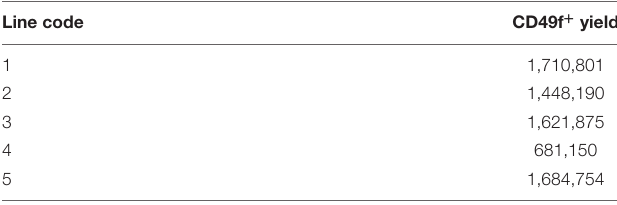
TABLE 4 | Human induced pluripotent stem cell -derived astrocytes collected for whole cell proteomic